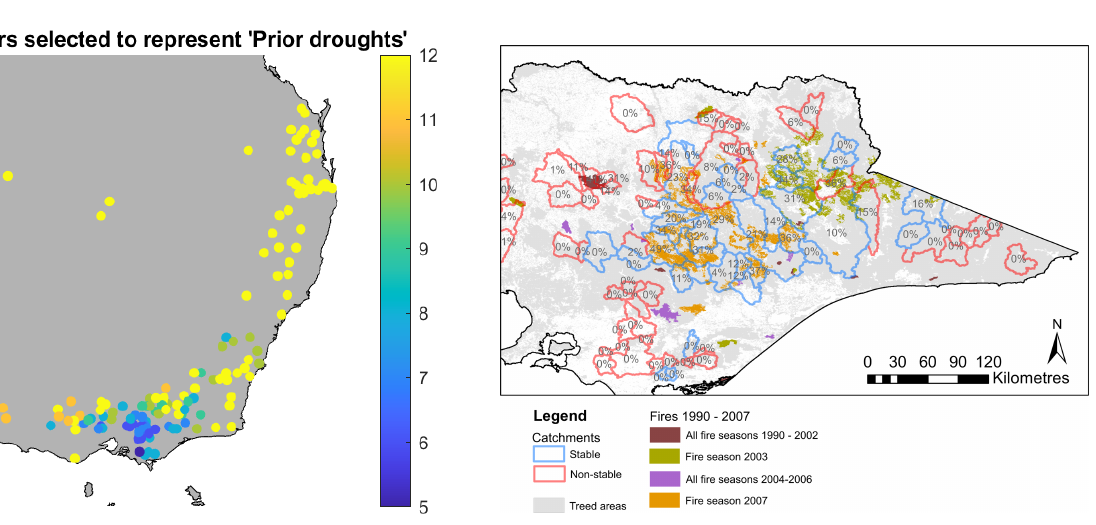
Figure E2. Fire history (most recent fire) over eastern Victoria, mapped with study catchments from Peterson et al.